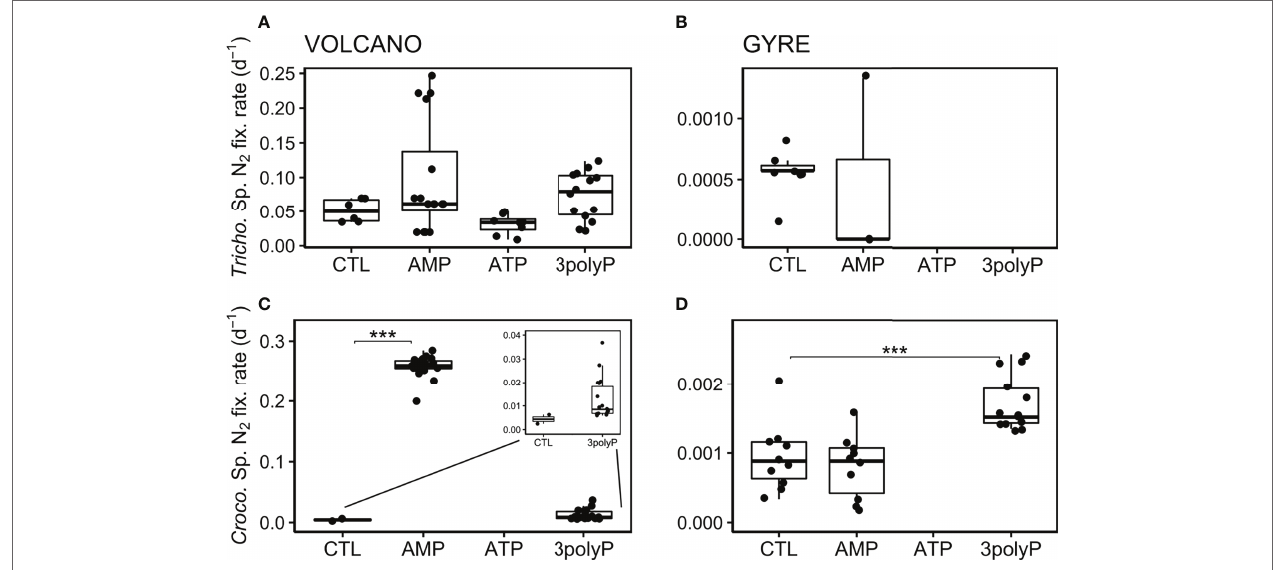
FIGURE 3 | Biomass-independent cell-specific N 2 fixation rates. Boxplots represent averaged cell-specific N 2 fixation rates derived from NanoSIMS per-cell enrichments over the experimental incubations. Each data point represents a single Crocosphaera and one or several averaged Trichodesmium ’s cell measurement as they showed similar enrichment values along the trichomes. No data is shown when cells were not found or identified. Significant differences in the cell-specific rates between the control and the DOP treatments were tested with the Dunnett’s Test and represented by the horizontal lines with significance codes (***p<0.001).